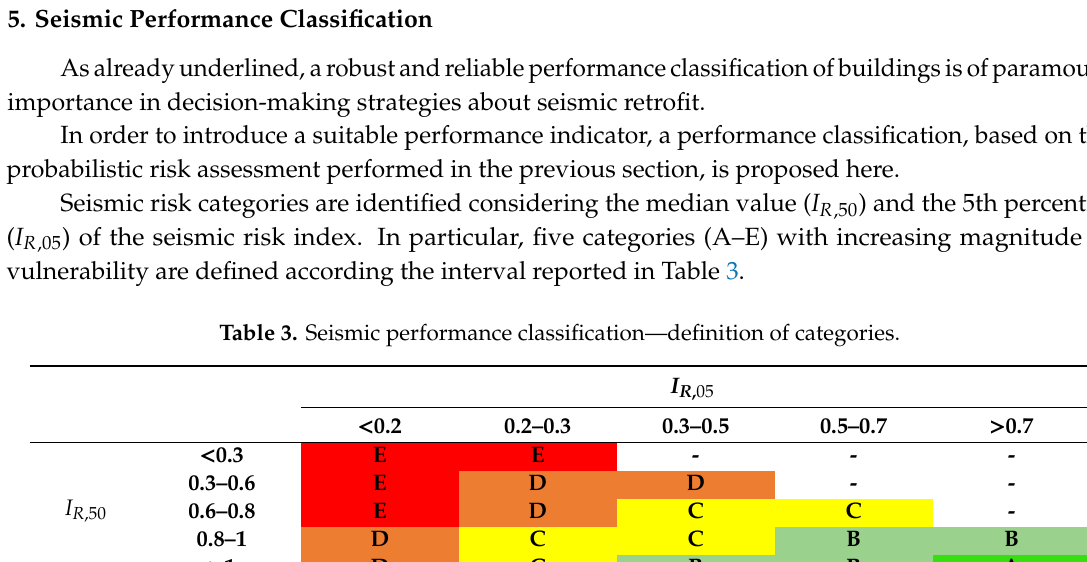
Figure 13. Box plot of seismic risk indexes for the 11 masonry buildings considered in the study.